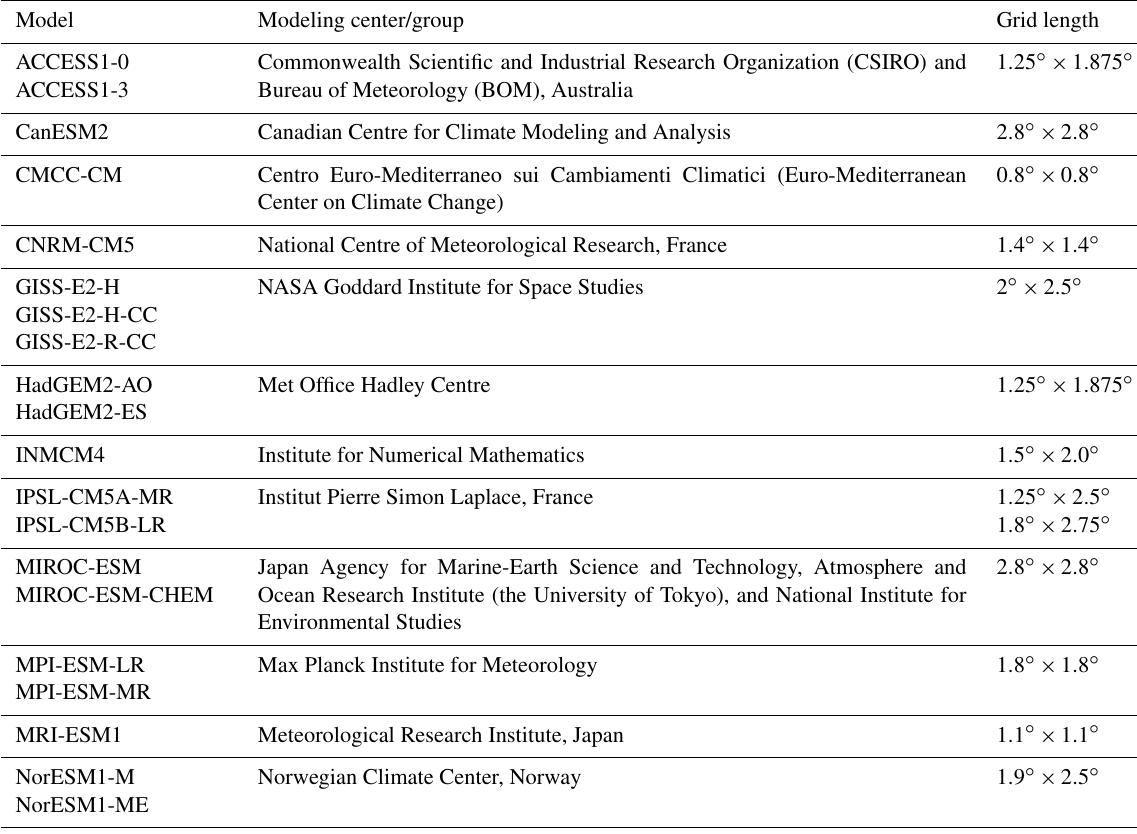
Table 2. List of 20 CMIP5 GCMs used to compute ensemble mean temperature “deltas” and sea ice fields.